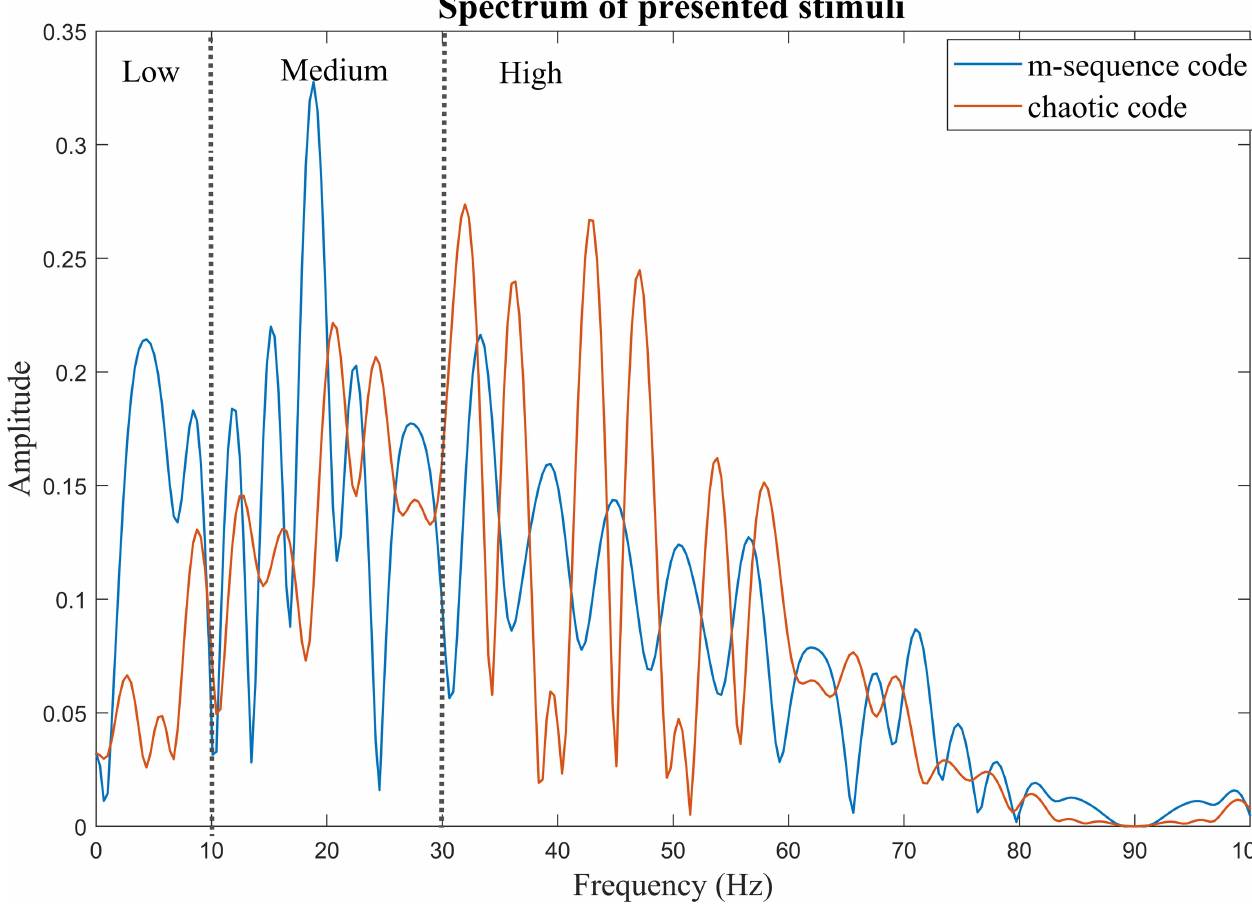
Fig 4. One-sided amplitude spectrum of the presented stimuli (blue: Spectrum of the m-sequence codes stimuli, red: Spectrum of the chaotic code stimuli). Dashed lines separate Low, Medium and High frequencies. Low: frequencies from 0 to 10 HZ, Medium: frequency range between 10 to 30 Hz and High: frequencies above 30 Hz. It is obvious that compared to the m-sequence codes, the chaotic codes frequency components are less in Low and Medium frequencies and are more in High frequency range.